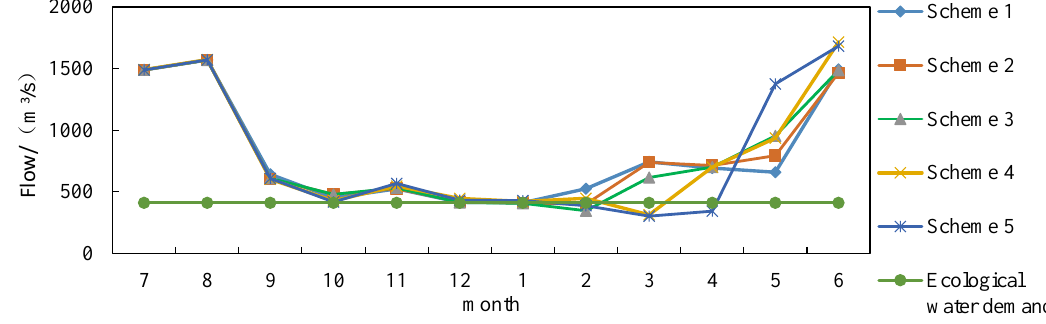
Figure 12. Comparative analysis of the outflow of Xiaolangdi in the dry year.